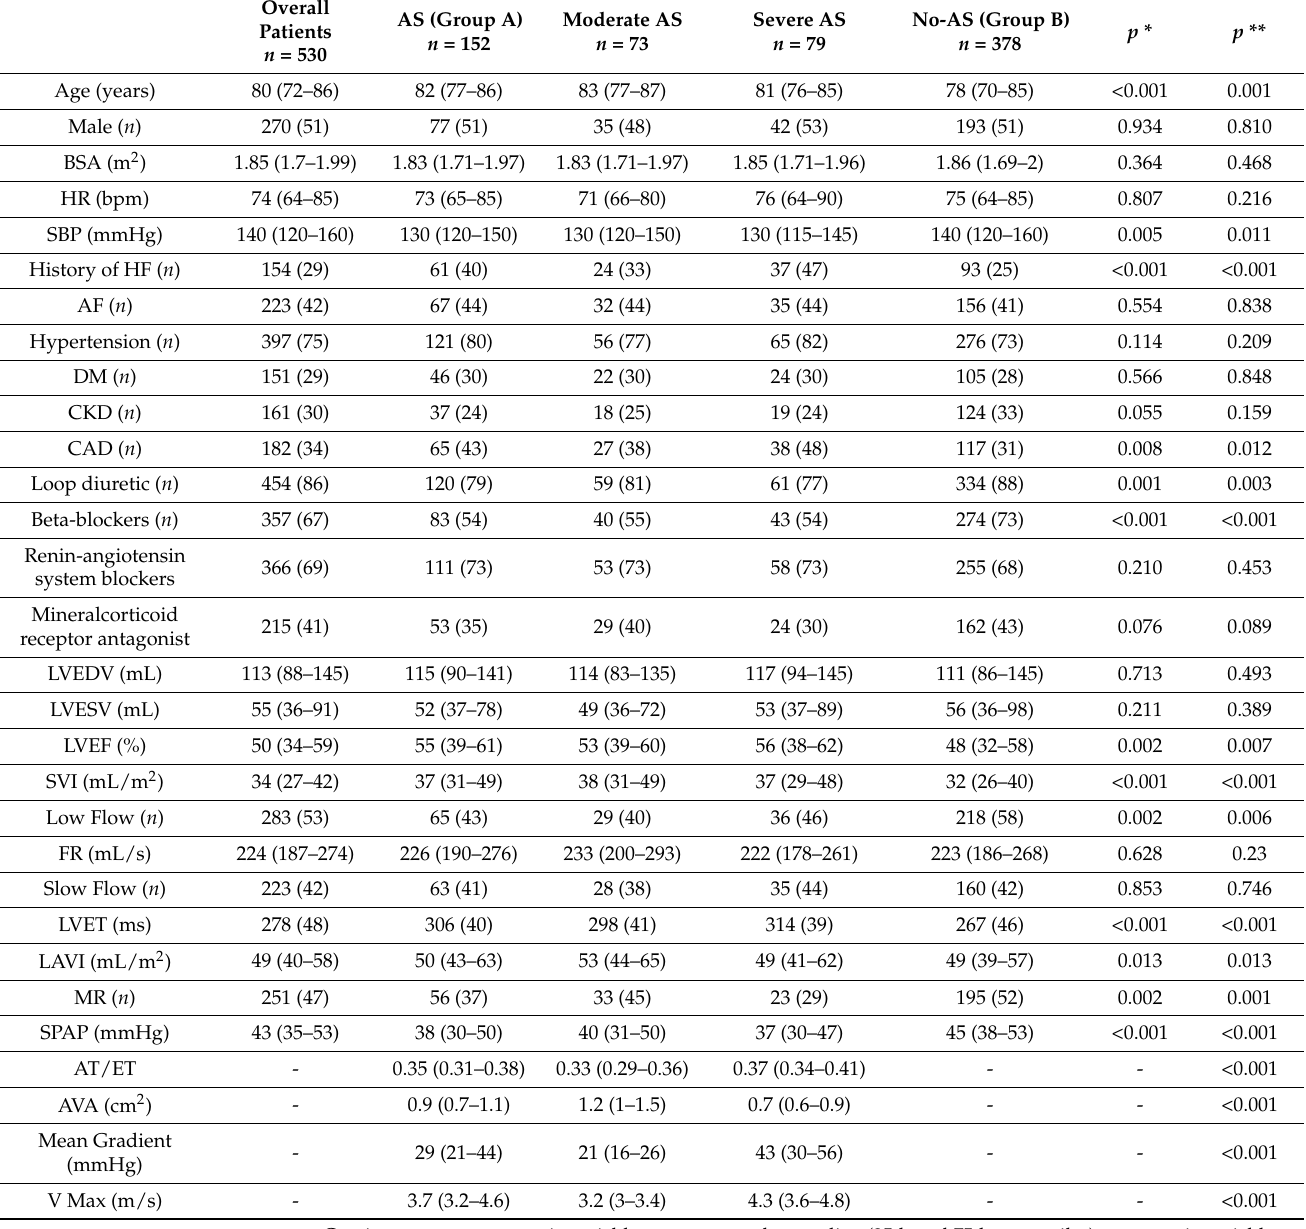
Table 1. Patient